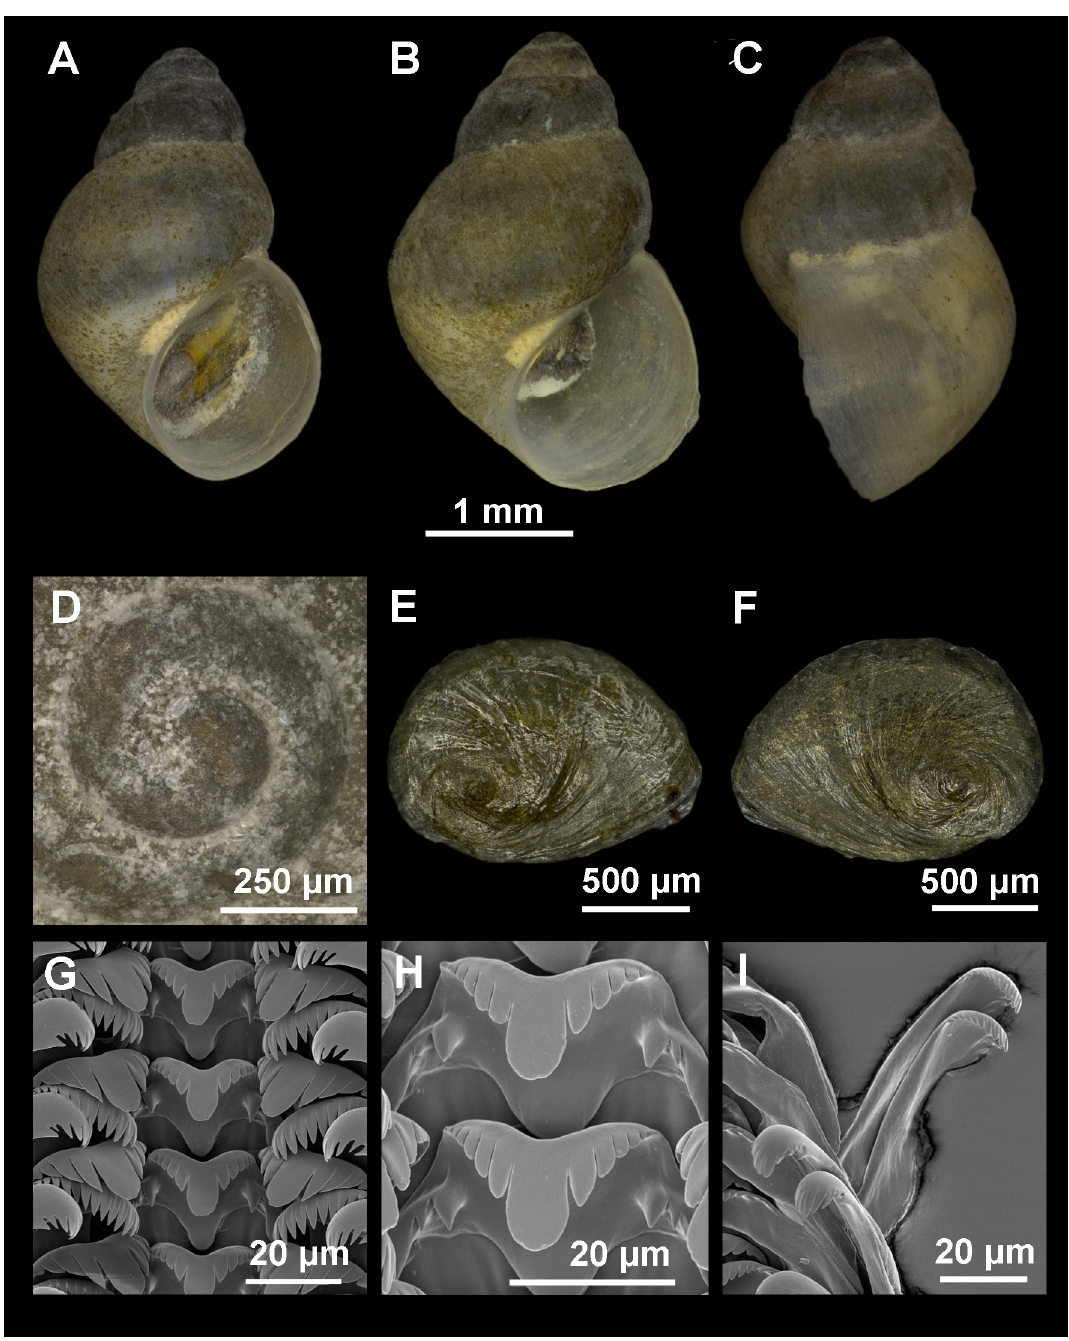
Fig. 2. Shell, operculum and radula of Intermaria zagrosensis (Glöer & Pešić, 2009) gen. et comb. nov. from Sar Pol Kangarar stream, Kermanshah Province, Iran. A–B . Shell in front view. C . Shell in lateral view. D . Protoconch and microsculpture. E–F . Internal and external side of the operculum. G . Rows of teeth of the radula. H . Central teeth. I . Detail of outer marginal